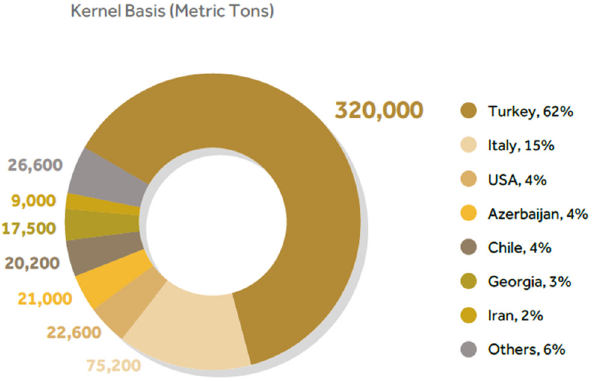
Figure 3. INC 2020/21 statistics for hazelnut production in kernel bases (metric tons) [3].